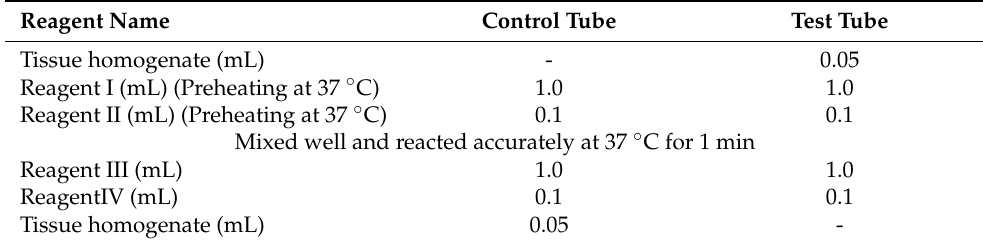
Table 2. Operation